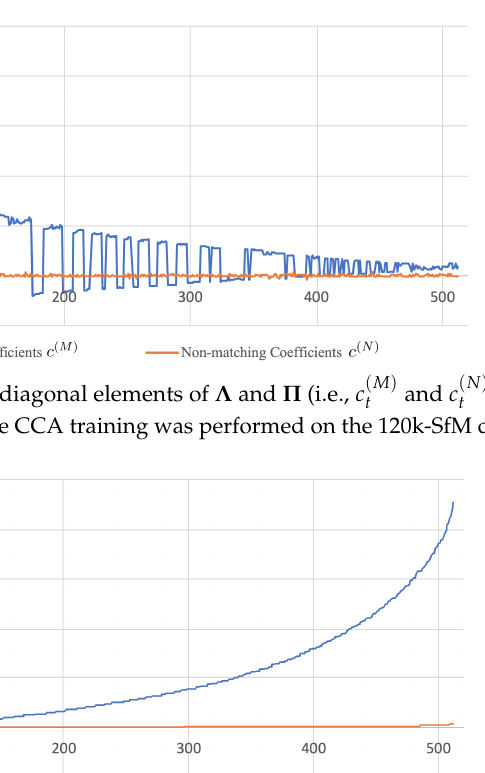
( M ) ( N ) and ˜ c , where t ∈ { 1,2, . . . ,512 } ) t t